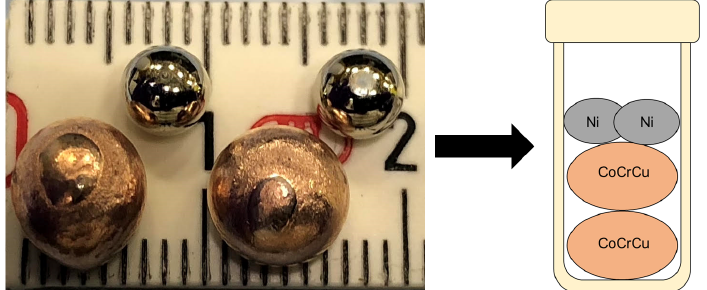
Figure 1. Photograph of the arc-melted CoCrCu buttons next to the remelted Ni buttons prior to the neutron imaging and melting.